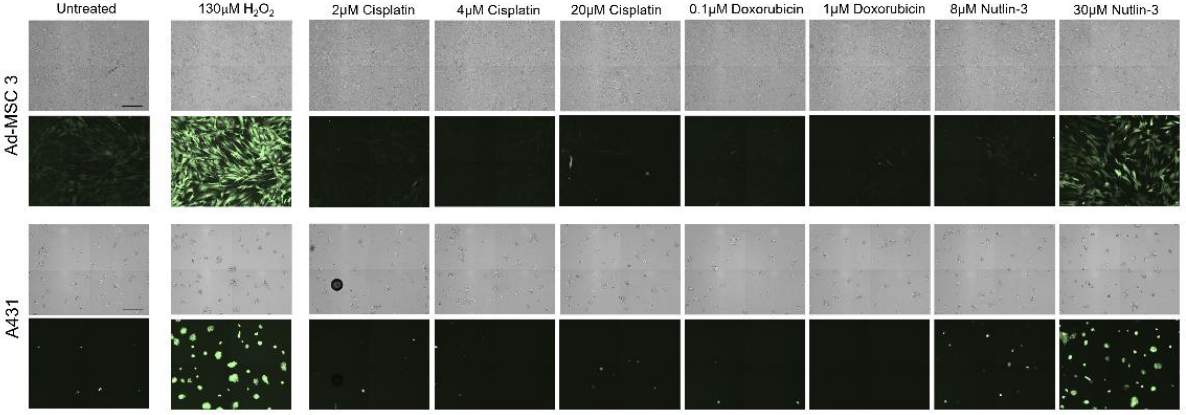
Figure 4. Assessing ROS content after drug treatment in Ad-MSC 3 and A431 cell lines. Brightfield ( upper row) and fluorescent ( lower row) images of A431 and Ad-MSC 3 after 1 h of drug exposure to indicated concentrations. Scale bar is 300 µM.